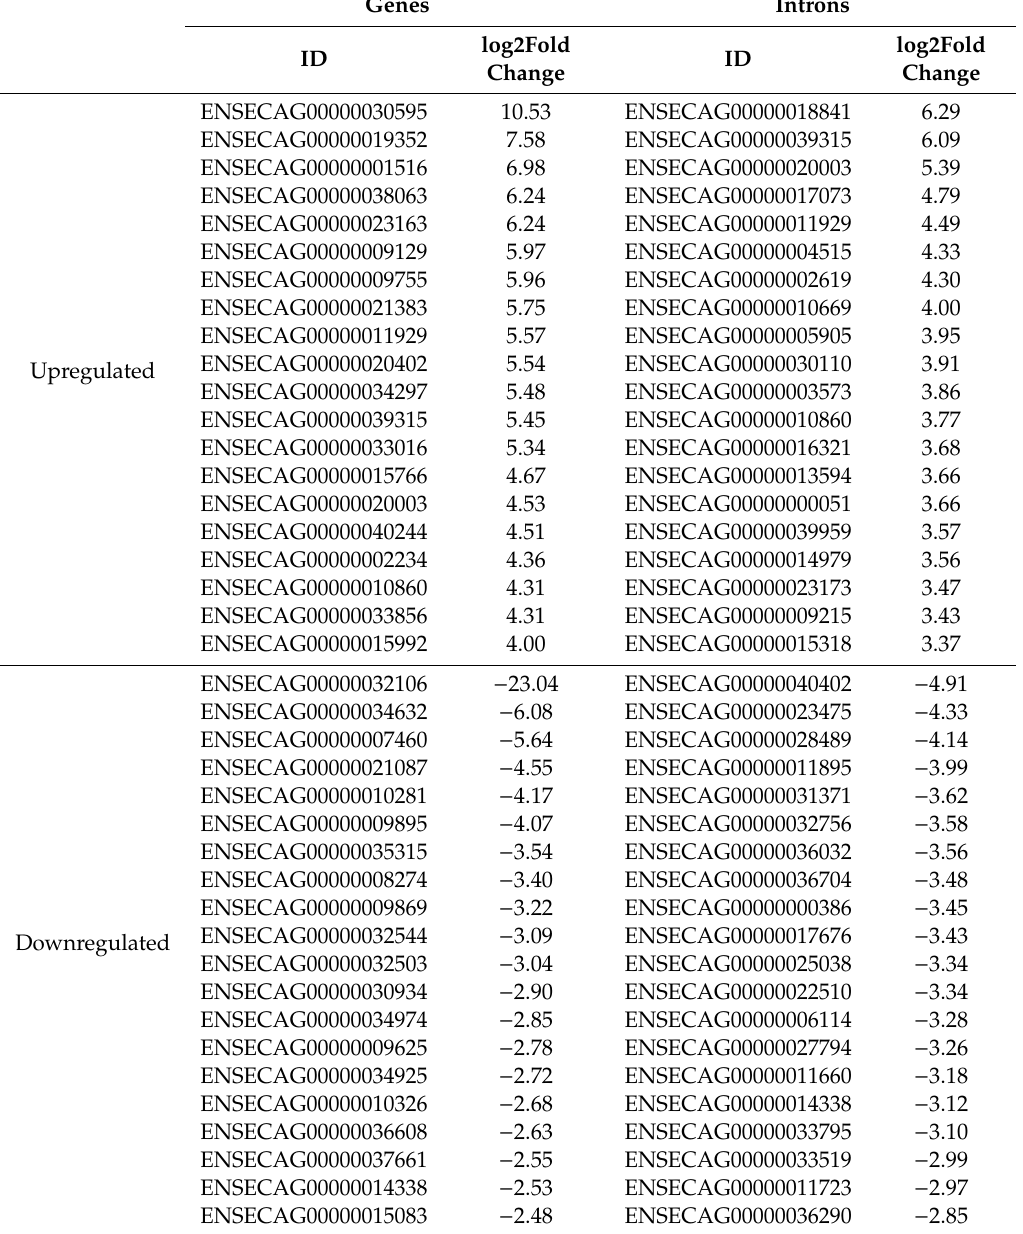
Table 3. Top 20 up and down di ff erentially expressed genes and